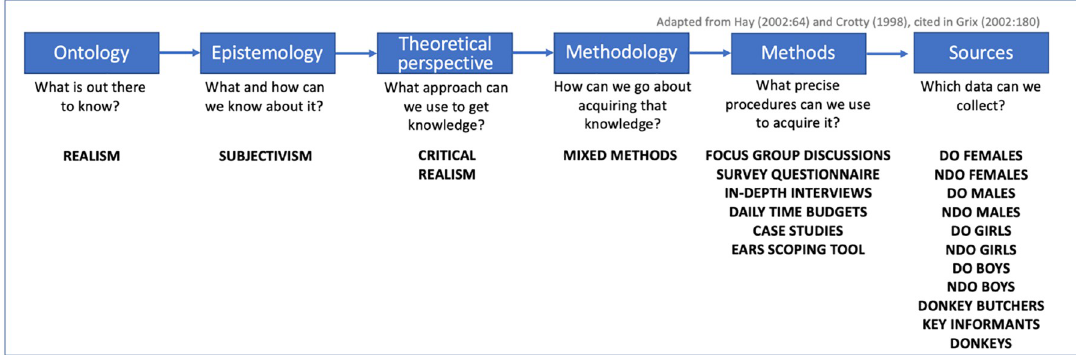
Fig 2. Summary of methodological relationships for this research. Source: adapted from Hay, (2002) and Crotty (1998), cited in Grix [43:180].